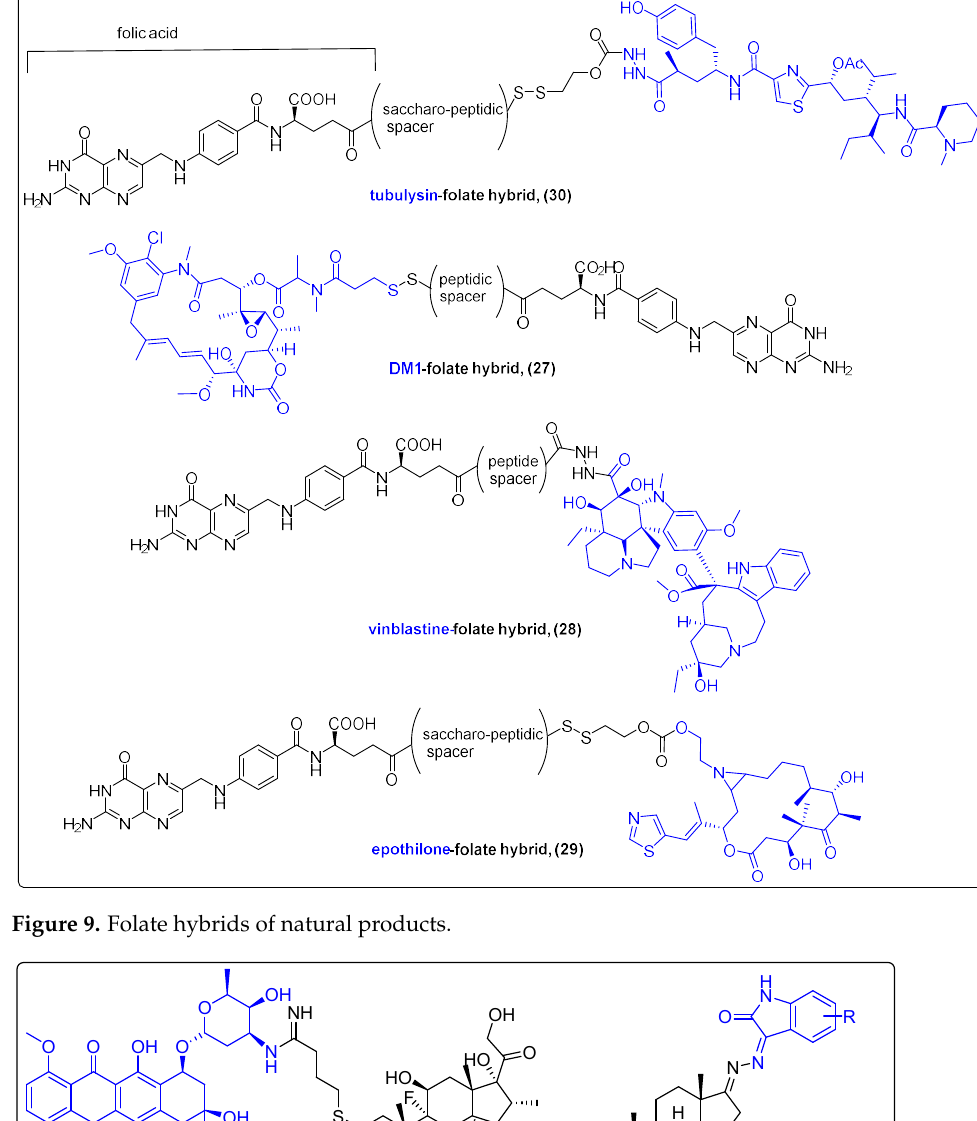
Figure 9. Folate hybrids of natural products.